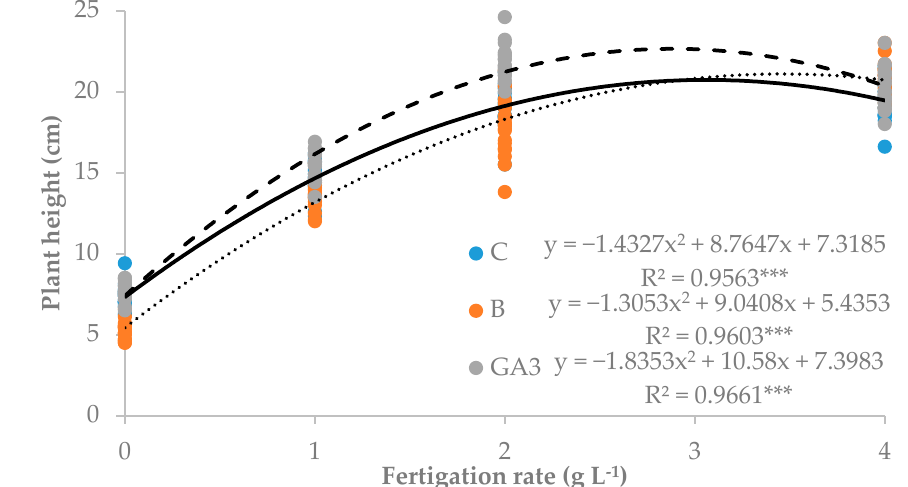
Figure 1. Quadratic predictions of the relationship between the fertigation rates (g L − 1 of NPK 20-20-20) and the seedling height values of untreated (C, continuous line), bacterial inoculated (B, dotted line), and gibberellic acid (GA 3 )-treated (GA3, dashed line) Solanum lycopersicum ‘Marmande’ seedlings (*** significant at p < 0.001). Table 1. Effects of the seedling treatments (C, untreated control, B, bacterial biostimulant, GA3, gibberellic acid spray 10 − 5 M) and the nursery fertigation rates (g L − 1 of NPK 20 ‐ 20 ‐ 20) on the morphological parameters of Solanum lycopersicum ‘Marmande’ seedlings.